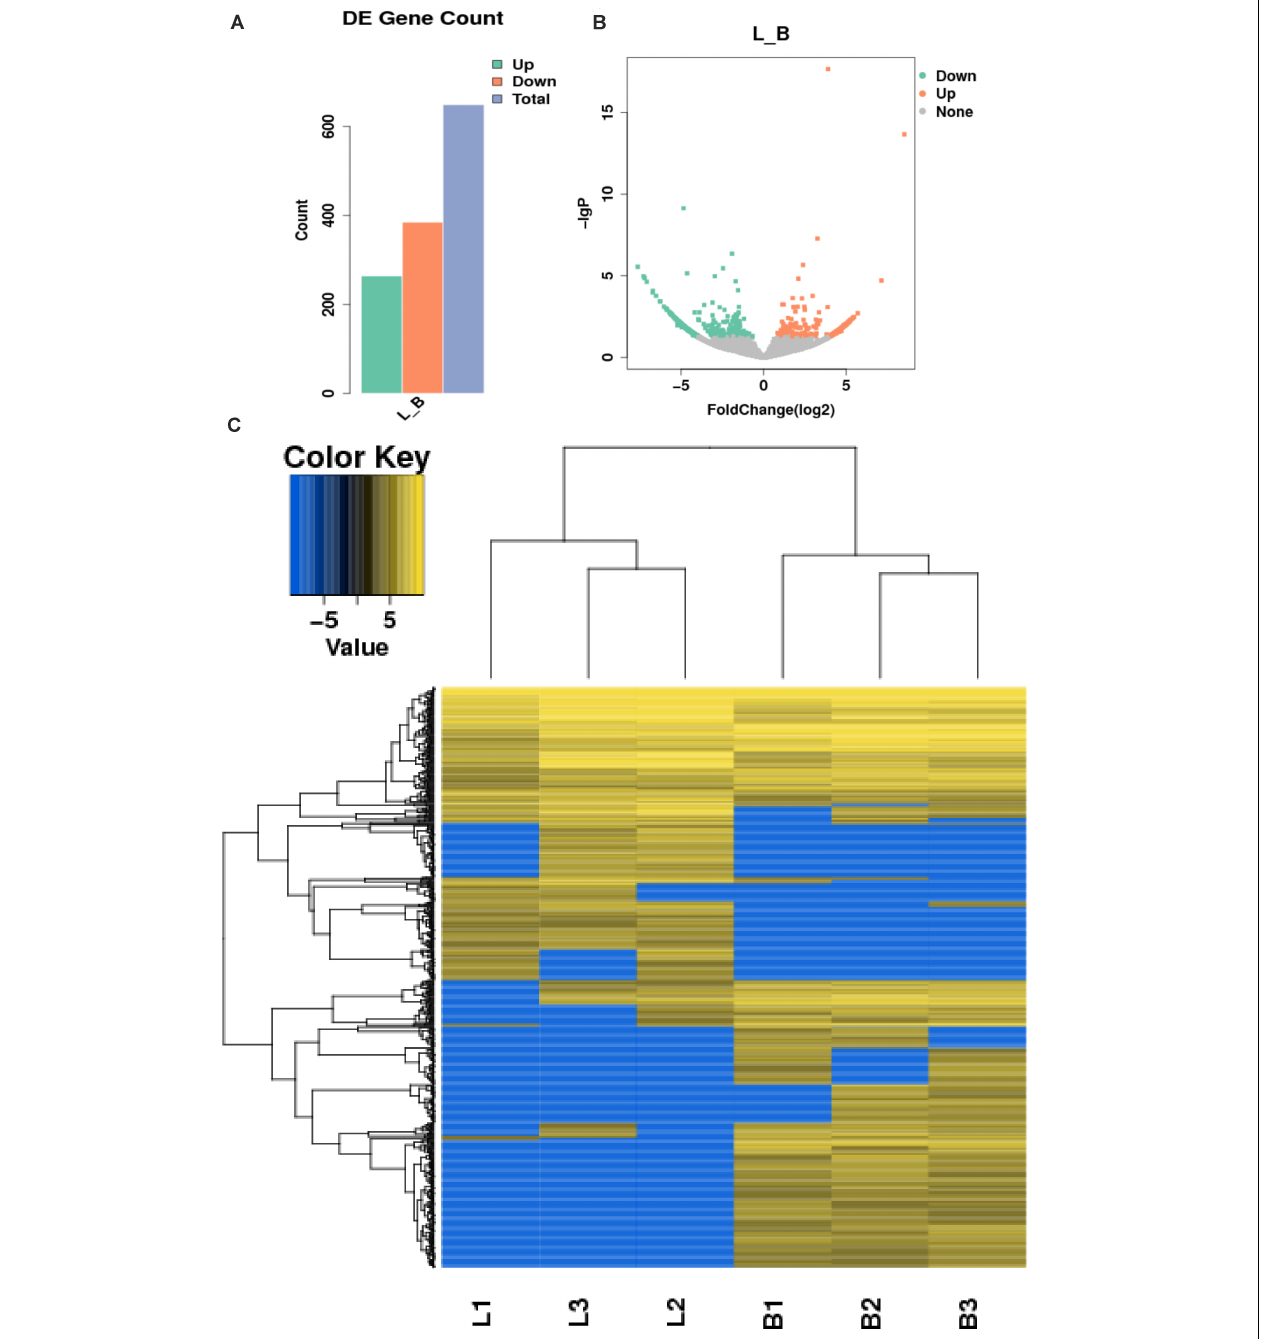
FIGURE 3 | Differential expression of circRNAs in the samples. (A) Statistical chart of the differential expression of 655 DE circRNAs, of which 267 were upregulated and 388 were downregulated; (B) Volcanic chart of differential circRNAs, the abscissa is the fold change of expression in L and B samples, the ordinate is the statistical significance of the change of expression. Different colors indicate different classifications: green (downregulated), orange (upregulated), and gray (the difference is not obvious); (C) Cluster heat map of differentially expressed genes. The change in expression quantity is represented by the change in color, blue represents lower expression levels, and yellow represents higher expression